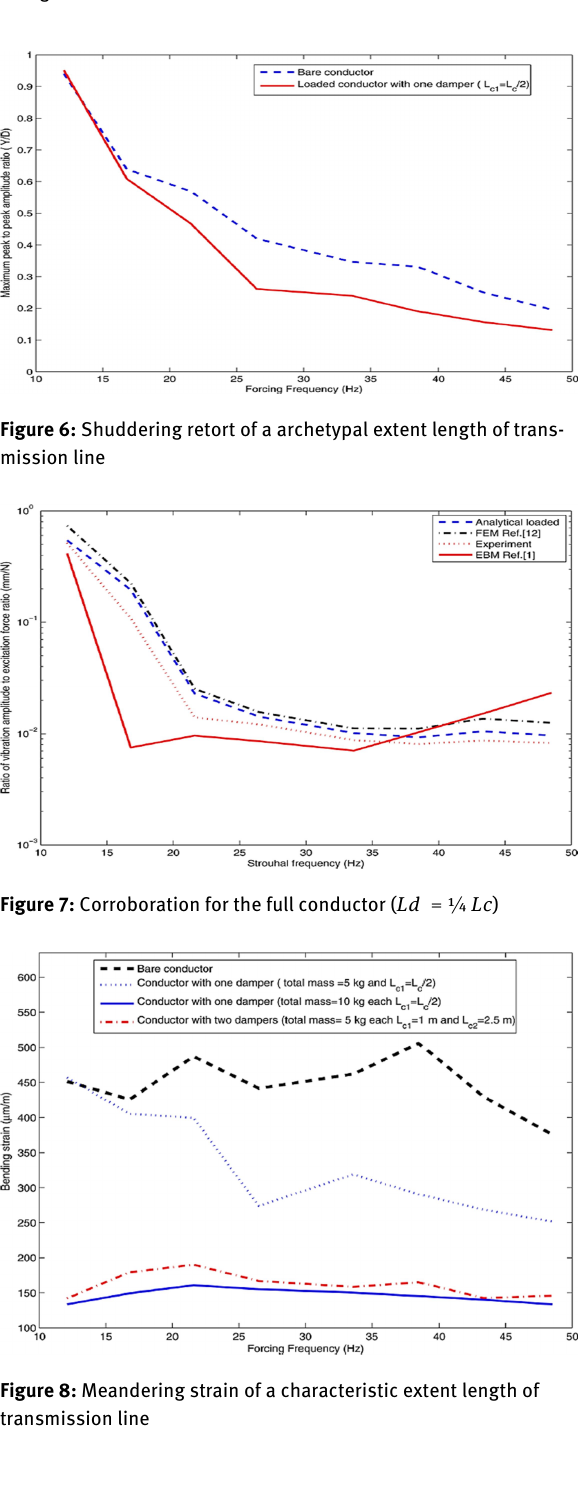
Figure 5: Corroboration for the undecorated electrode